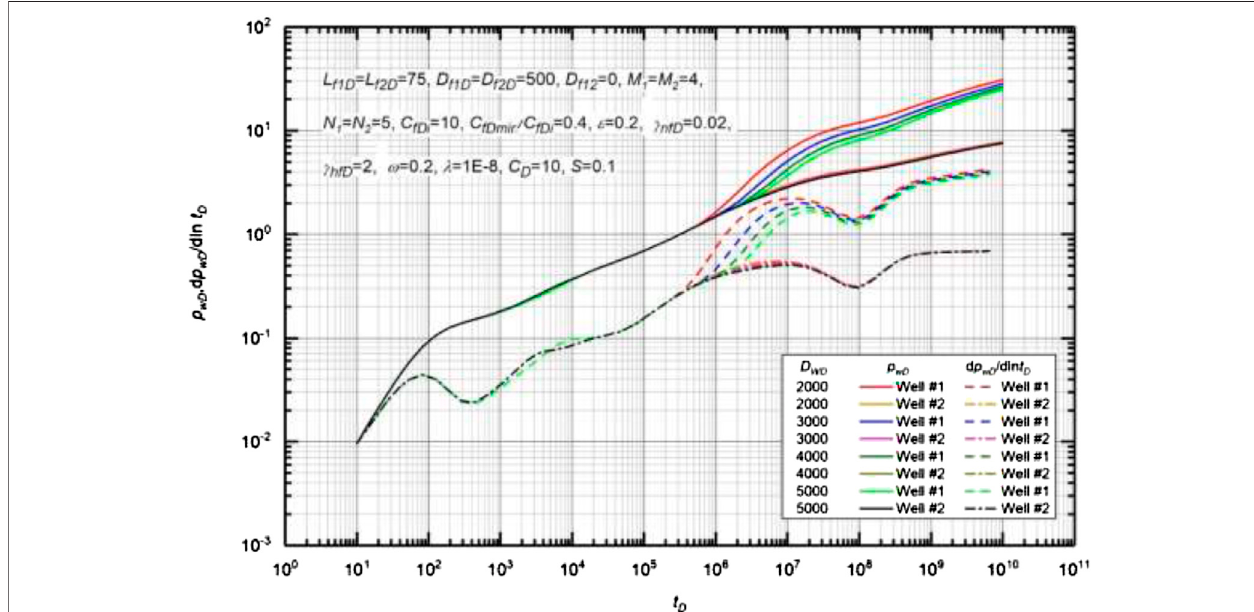
FIGURE 12 | Effect of well spacing on the transient pressure for MWPMF.